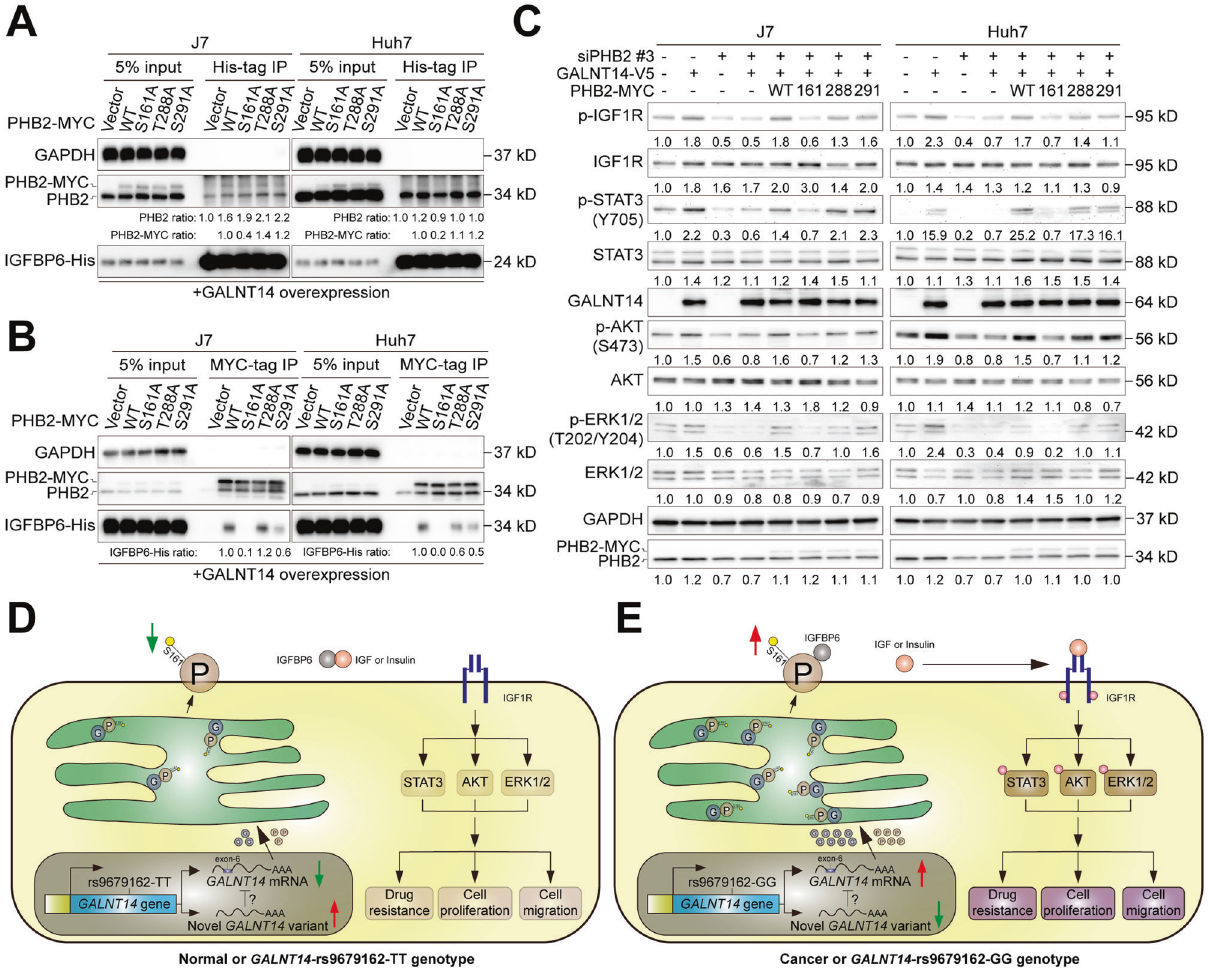
Fig. 7 GALNT14-mediated O -glycosylation of PHB2 at Ser161 promotes IGF1R-mediated signaling through the association of PHB2 with IGFBP6. A , B Western blot analysis of co-immunoprecipitation assays using HCC cell samples treated as indicated. C Western blot analysis of HCC cell lysates treated as indicated. D , E Working model of this study. The newly discovered short RNA variant of GALNT14 is present and able to attenuate the expression of exon-6-containing mRNA in normal hepatocytes or in patients carrying the rs9679162-TT genotype. Consequently, lower levels of GALNT14, PHB2, and O -glycosylated PHB2 are produced, preventing activation of IGF1R-mediated signaling ( D ). However, in cancerous hepatocytes or patients carrying the rs9679162-GG genotype, the novel RNA variant of GALNT14 was absent and failed to suppress the expression of mRNA containing exon-6, resulting in increased levels of GALNT14, PHB2, and O -glycosylated PHB2. The increase in O -glycosylated PHB2 competes for binding with IGFBP6, thereby increasing IGF (or insulin) release to activate the IGF1R-mediated signaling